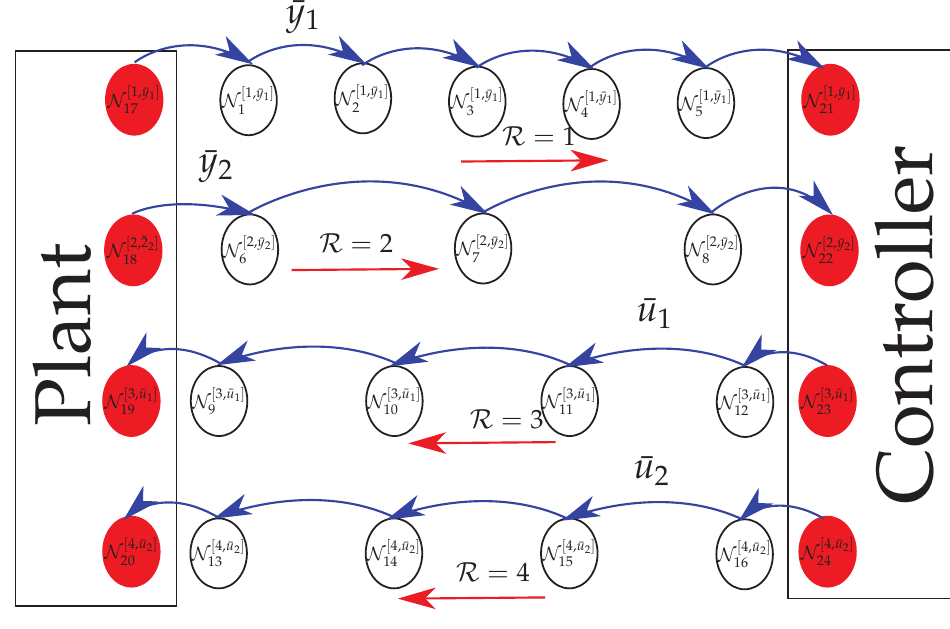
Figure 4. Network topology for the experiment presented in Section